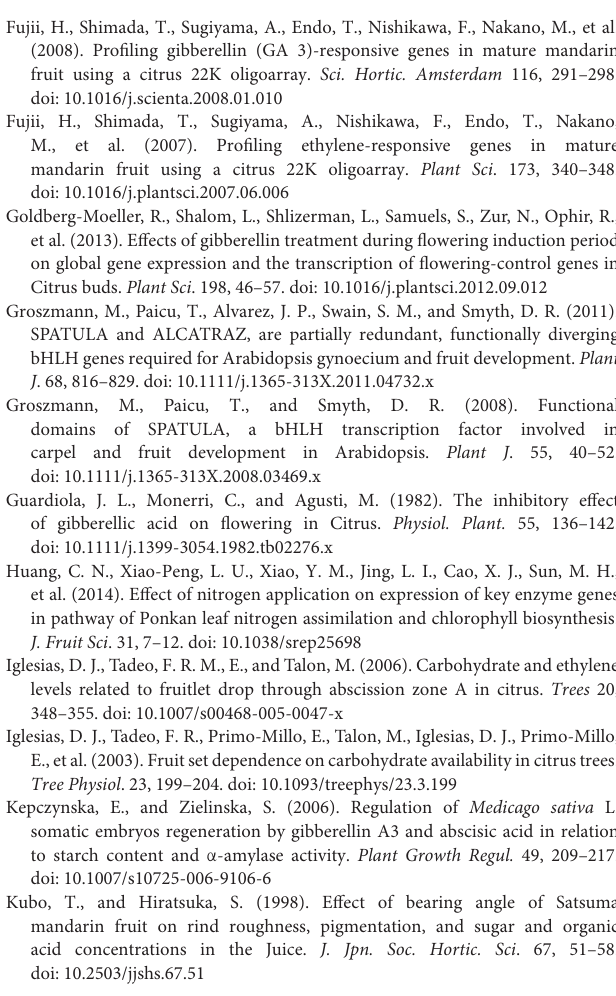
Figure S1 | Sucrose (A) , fructose (B) , glucose (C) , citrate (D), and malate (E) accumulation in CK and RD pulp during fruit development. Asterisk means significant difference at P < 0.05. Figure S2 | TSS (A) , sucrose (B) , fructose (C) , glucose (D) , citrate (E), and malate (F) accumulation in pulp after hormone treatments. Different letters mean significant difference at P < 0.05. Figure S3 | Relative expression of genes involved in GA signal transduction. Values are mean ± SD of three biological replicates calibrated against the amount of β -actin control expression. Numbers at the top of the columns represent the FPKM values calculated from sequencing